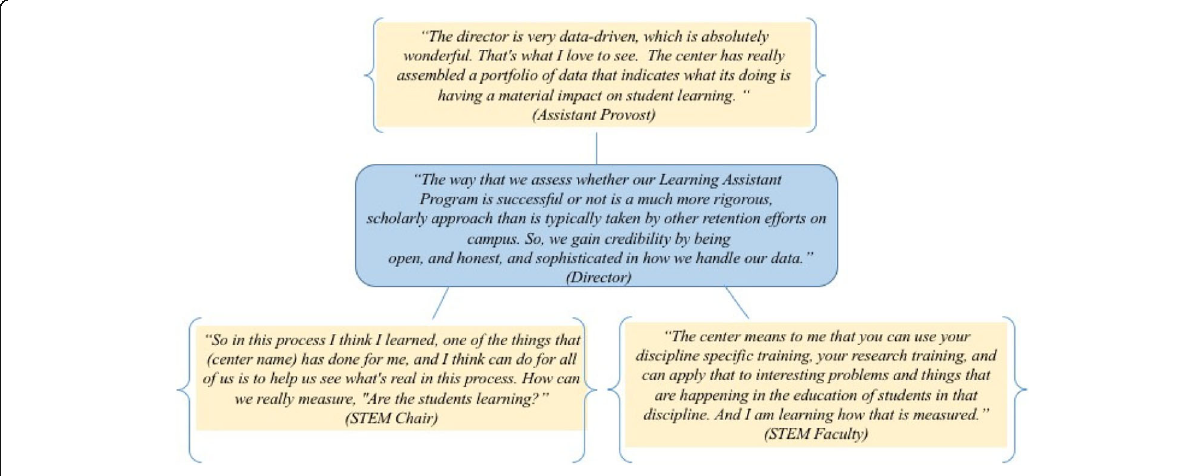
Fig. 1 SEC role in educational research. A representative example from Institution